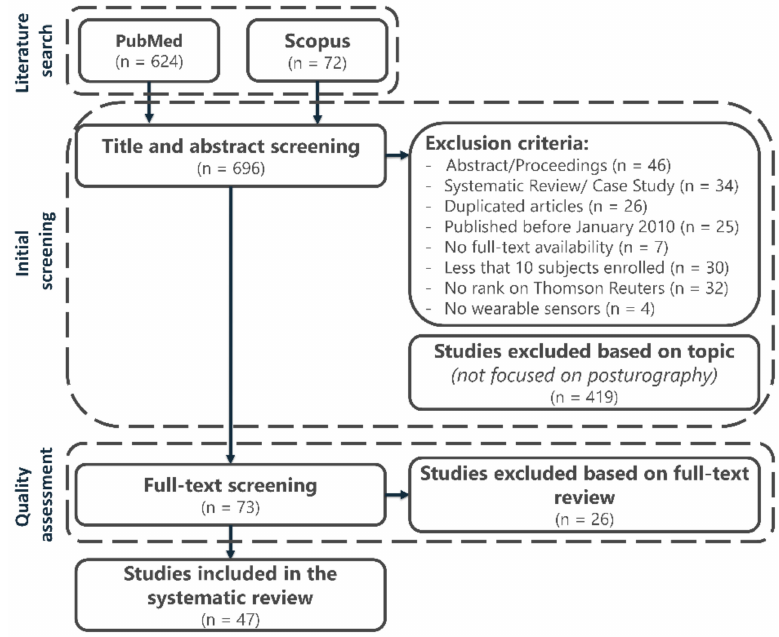
Figure 1. Flow diagram of the systematic search strategy and the review process.